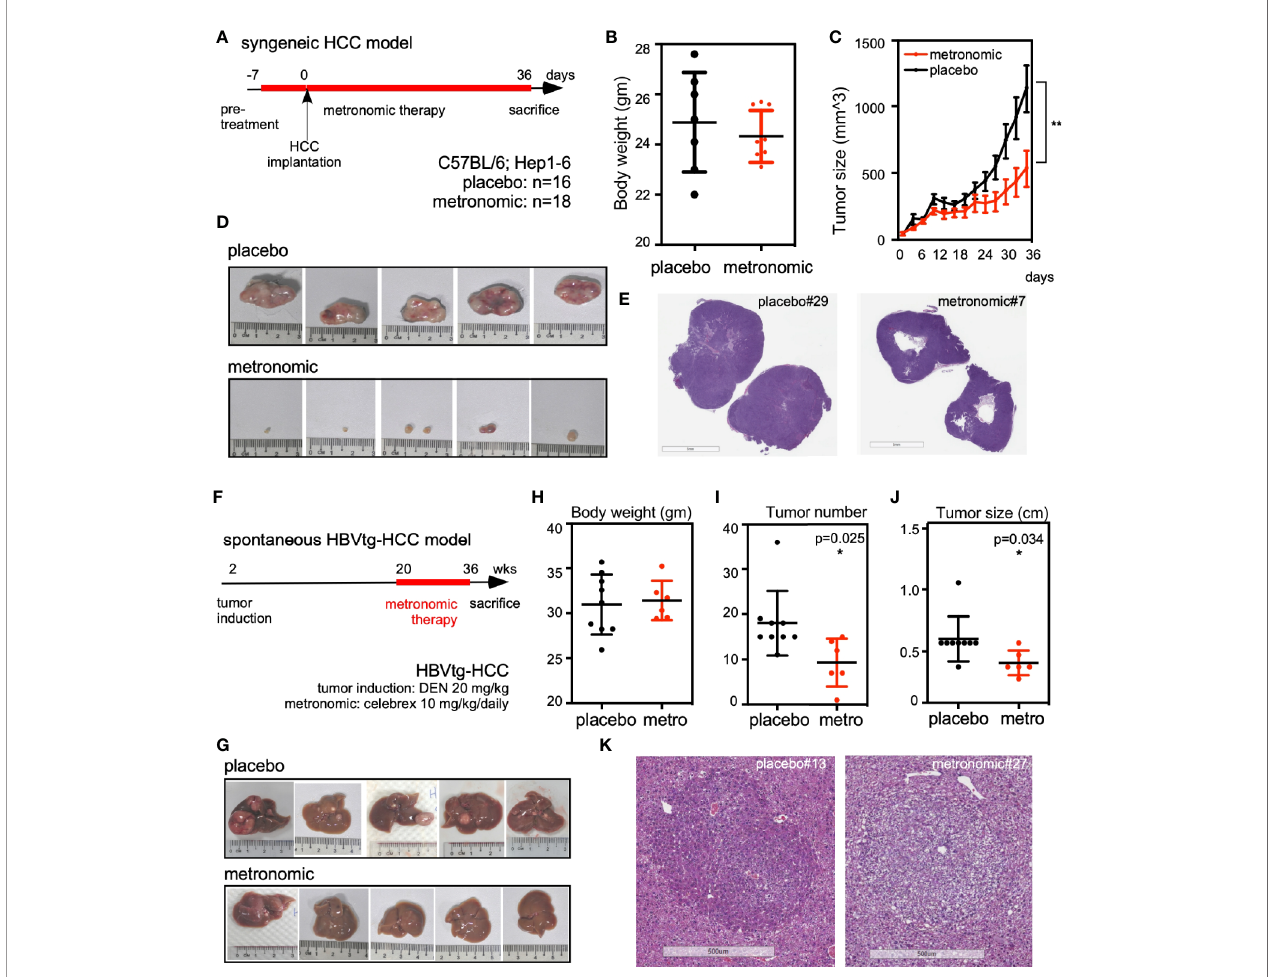
FIGURE 1 | Metronomic Celecoxib signi fi cantly suppressed in vivo tumor regrowth of seeded syngeneic HCC and spontaneous hepatocarcinogenesis in the HBVtg- HCC model. (A) Protocol of metronomic Celecoxib on the syngeneic HCC implantation model. C57BL/6 mice were pretreated with metronomic Celecoxib (10 mg/ kg/d) orally before implanting Hepa1-6 cells (10 6 /implantation site) into bilateral fl anks. After implantation, these mice were treated with either metronomic Celecoxib or placebo for another 36 days and sacri fi ced on the 37 th day for measurement. (B) The bodyweight of mice was comparable between the placebo and the “ metronomic Celecoxib ” group. (C, D) The implanted Hepa1-6 HCC tumor size was signi fi cantly suppressed in the “ metronomic Celecoxib ” group when compared to the placebo group (day-37 tumor size [mean ± SEM] = 539.8 ± 135.8 mm 3 vs. 1138.0 ± 175.0 mm 3 , P < 0.01). (E) H&E stain showed signi fi cant central necrotic portion of HCC in the “ metronomic Celecoxib ” group at the syngeneic HCC model. (F) Protocol for spontaneous hepatocarcinogenesis in the HBVtg-HCC model. HBV transgenic mice (HBVtg) mice were given Diethylnitroasamine (DEN; 20 mg/kg) intraperitoneally at the age of 14 th day. Metronomic Celecoxib (10 mg/kg/d) or placebo was fed from the age of 20 th week to 36 th week. Then, the mice were sacri fi ced for the measurement of liver tumors. (G) Spontaneous hepatocarcinogenesis in the harvested liver from the “ metronomic Celecoxib ” group was grossly less than that in the placebo group. (H – J) Bodyweight of mice was also comparable between the “ metronomic Celecoxib ” group and the placebo group. Tumor number and tumor size were signi fi cantly reduced in “ metronomic Celecoxib ” group compared to placebo group (tumor number [Mean ± SEM] = 9.3 ± 2.2 vs. 18.0± 2.4, P < 0.05; tumor largest diameter [Mean ± SEM] = 3.3 ± 0.4 mm vs. 5.3 ± 0.6 mm, P < 0.05). (K) H&E staining at comparable-sized HCCs showed less eosinophilic staining in the “ metronomic Celecoxib ” group compared to the placebo group in HBVtg-HCC model. * Indicates P < 0.05 and ** indicates P <